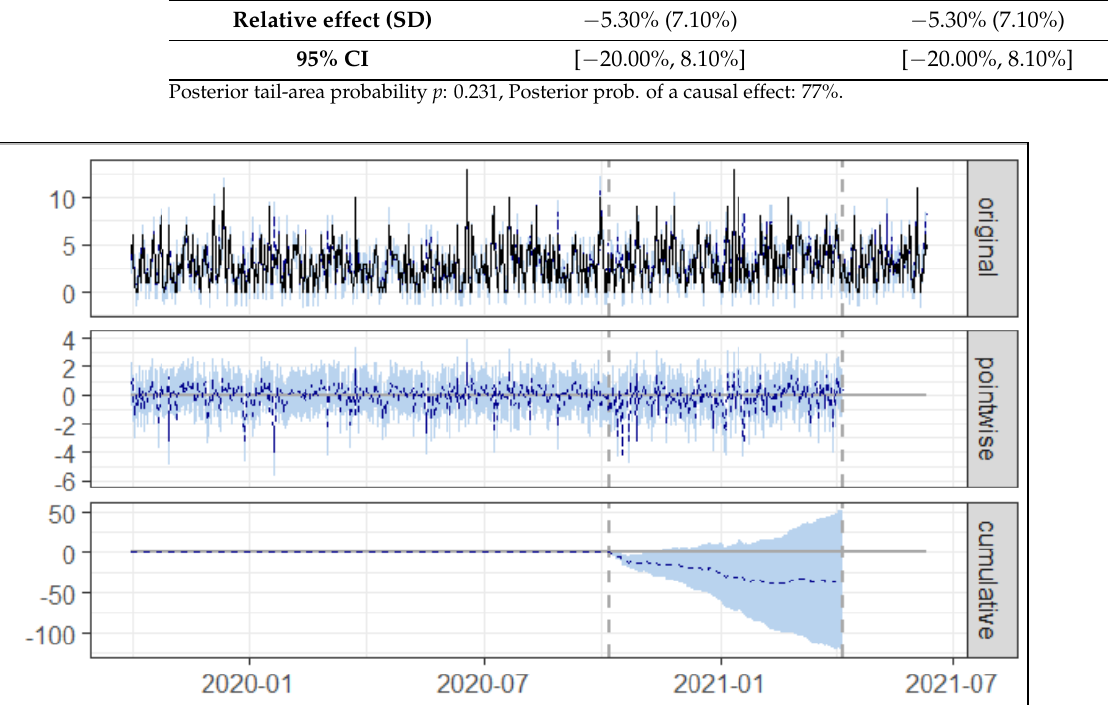
Figure 5. The trend of prescription of Octasa ® prior to and during the implementation of intervention 1. Note: The first panel shows the data and a counterfactual prediction for the post-treatment period. The second panel shows the difference between observed data and counterfactual predictions. This is the pointwise causal effect, as estimated by the model. The third panel adds up the pointwise contributions from the second panel, resulting in a plot of the cumulative effect of the intervention.